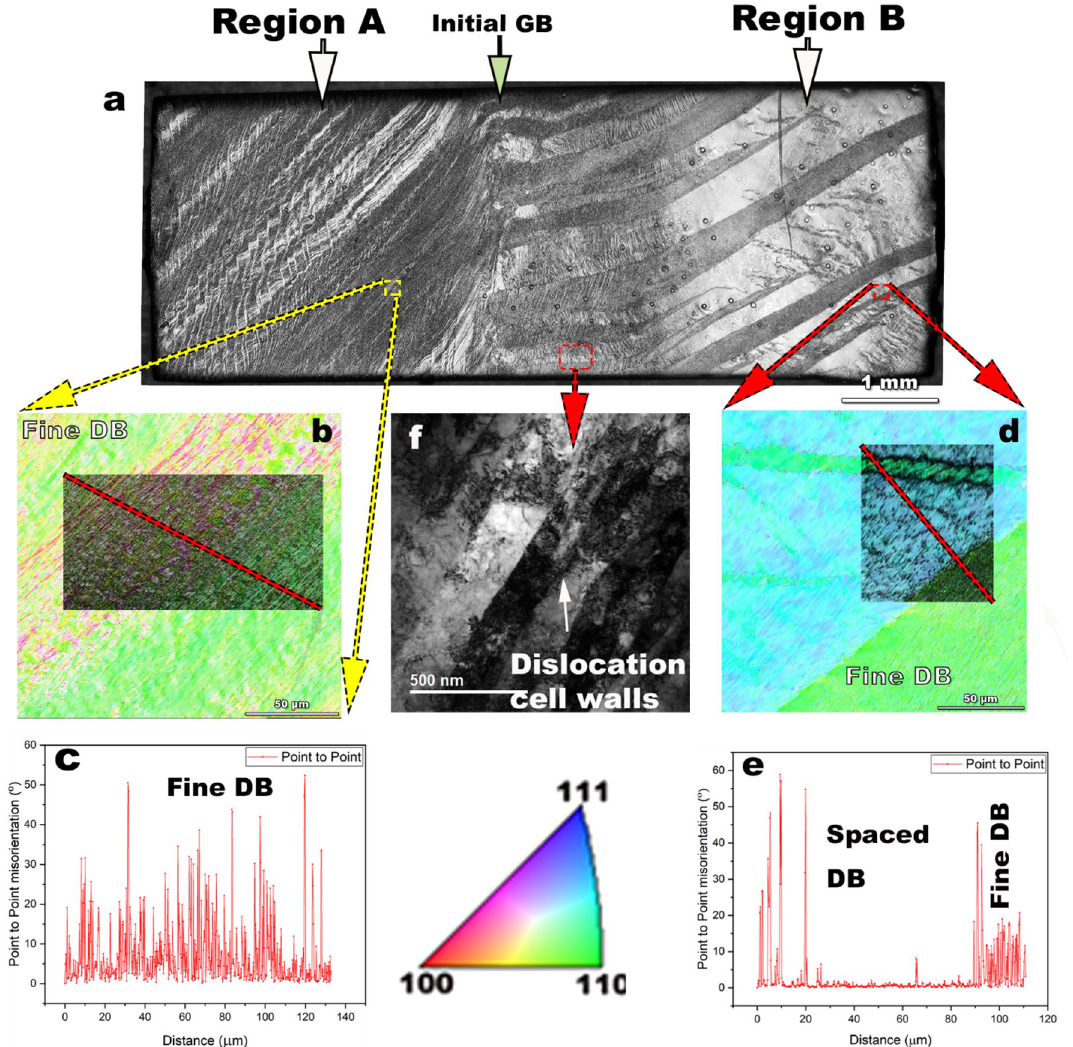
Figure 1. The simple shear deformation of the Nb bi-crystal produces differences in deformation structures depending on initial crystal orientations as shown by ( a ) a light microscope image of the polished and lightly etched surface indicating deformation band (DB) structures that occur in high purity Nb, ( b , d ) which are inverse pole figure (IPF) maps of regions showing predominant differences in DB structure between Region A, and Region B, and c) and ( e ) which show the variations in misorientation angles as a function of location, marked by the red lines in IPF. Uniform variations of misorienation in Region A are distinguished by alternating sparse-fine DB in Region B. The legend describes the color codes for grain orientation. The IPF’s were generated using the TSL OIM Analysis (Version 7.0), link: https ://www.edax.com/produ cts/ebsd/oim-analy indicates that the grain boundaries in this duplex grain structure are produced by the stacking of dislocations. From the TEM images, we conclude that after 1000 °C, there is recrystallization and growth of new grain orienta- tions in Nb, replacing the deformation microstructure even in the fine grain regions. In summary, the initial grain orientation plays a significant role in the deformation structures, and it varies spatially. During successive heat treatments, recovery processes are supposed to be pre-dominant at a tempera- ture range of 600–800 °C. After 1000 °C/3 h heat treatment, recrystallization and significant grain growth have occurred in the deformed Nb. A characteristic change in the textures before and after 1000 °C/3 h is evident. However, the microstructure is non-uniform spatially. The deformation band region consists of fine grains (30–50 µm), whereas the region with widely spaced deformation bands develops a duplex microstructure with large grains of the order of 100–400 µm, and adjacent 30–50 µm fine grain size bands. Detection of magnetic flux penetration and trapping by Magnetic Optical Imaging (MOI). To understand the microstructural influence on penetration and trapping of magnetic flux, we performed MOI along with deformation and heat treatments. The results presented here are after 800 °C/3 h and 1000 °C/3 h at temperatures 6.5 and 6.8 K, respectively, where Nb (T c ~ 9.2 K) is in the fully superconducting state (supplemen- tary section Figure S1contains results of sample after deformation + etching, and 600 °C/3 h heat treatment).